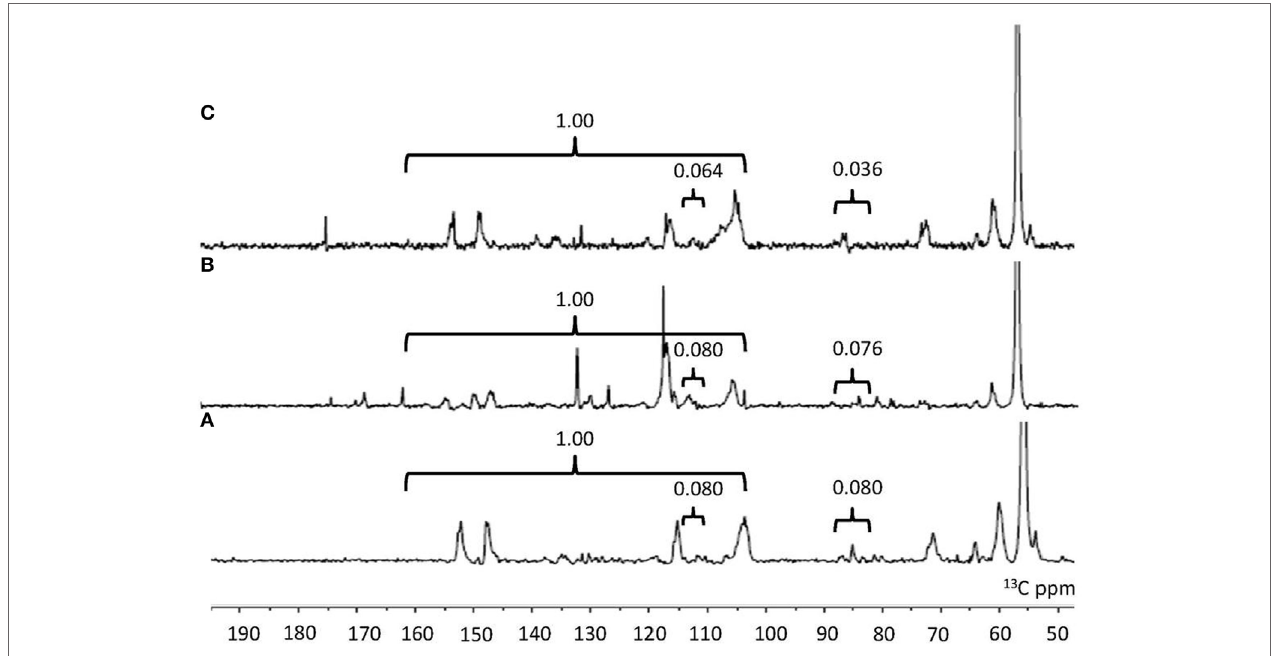
FigUre 2 | 13 C-NMR spectra and integration value of lignin samples (a) NO.1 lignin. (b) NO.2 lignin. (c) NO.3 lignin. 160–102 ppm in the quantitative 13 C nuclear magnetic resonance was representative of the total carbon atoms from all aromatic rings within the lignin. 119–113 and 88–82 ppm was used as internal standard in the aromatic and aliphatic